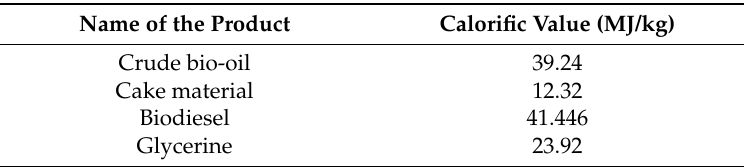
Table 6. Gross heating value or calorific value of the crude mandarin oil, cake materials, biodiesel and